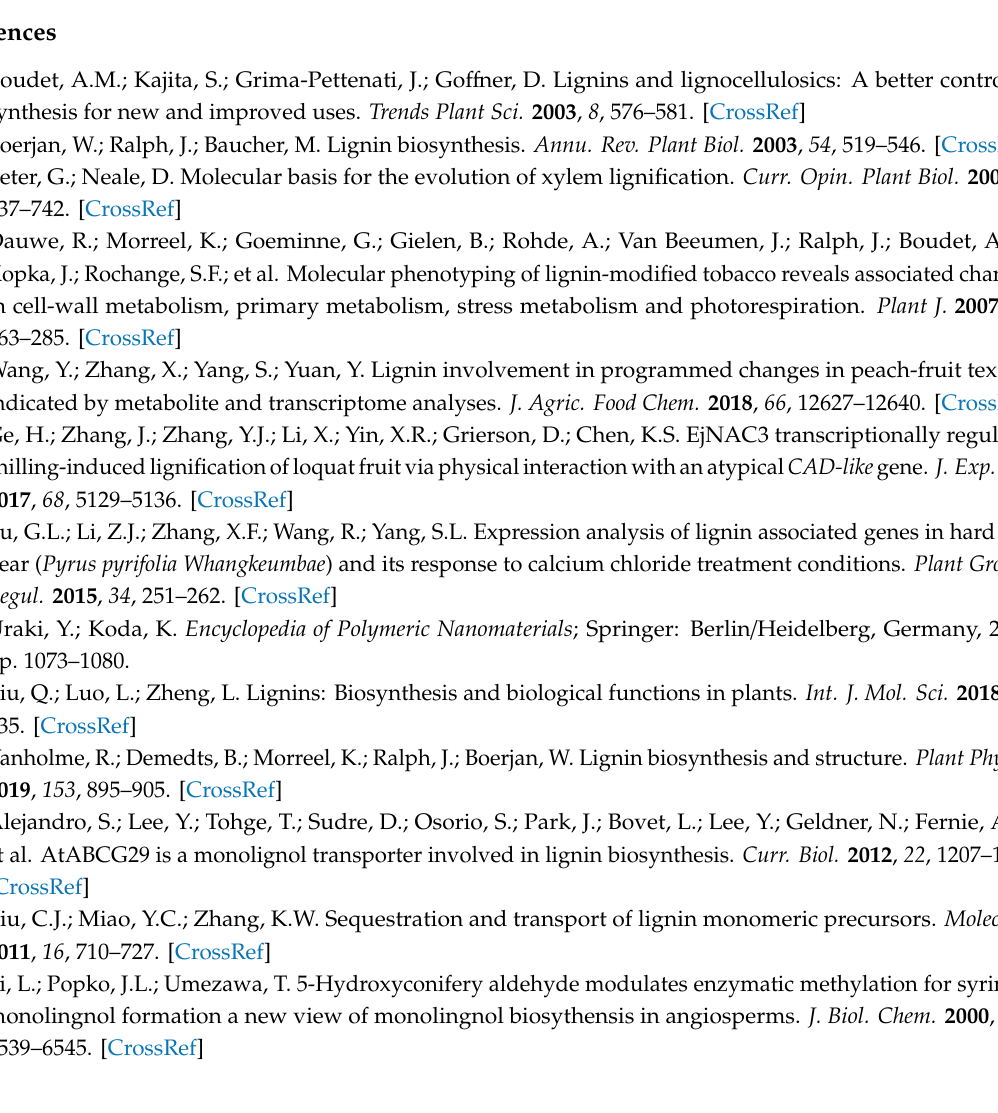
Supplementary Materials: Figure S1: PpCAD2 sequence analysis, Figure S2: Generation of transgenic tomato ‘Micro-Tom’, Figure S3: PCR identification of transgenic ‘Micro-Tom’ plants with the PpCAD2 constructs. Author Contributions: S.Y. and X.Z. conceived and designed the experiments, M.L. and C.C. performed the experiments and analyzed the data, S.Z. and S.Y. wrote the manuscript, L.L. analyzed the partial data. All